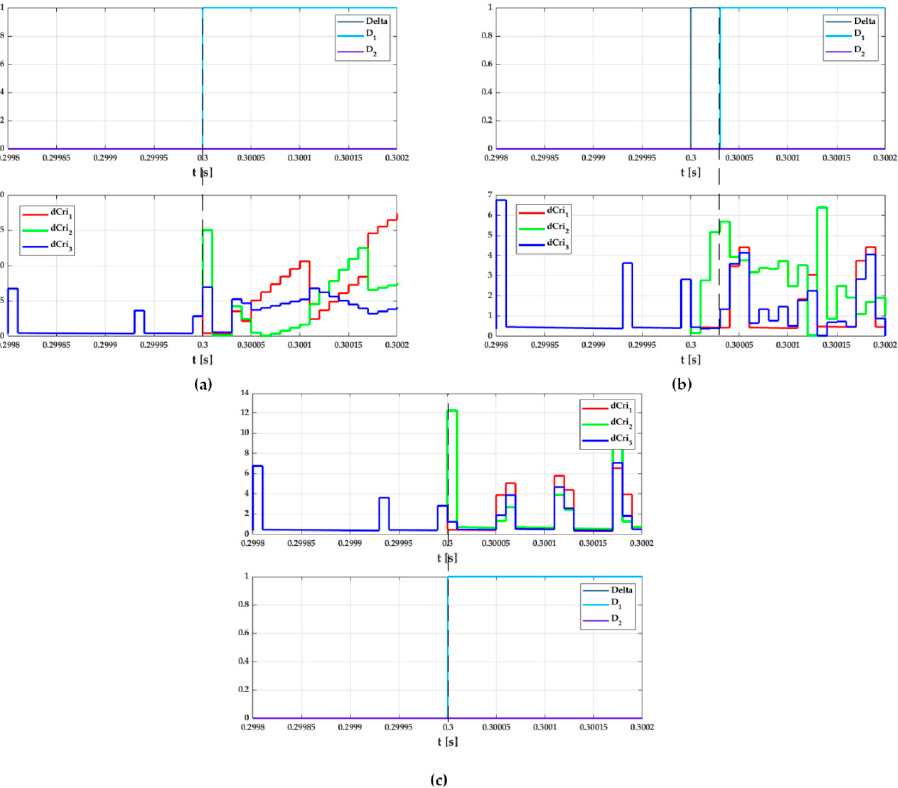
Figure 3. Detector responses and transients of marker errors during lack of signal: ( a ) measurement white Gaussian noise (20 dB); ( b ) variable gain (1.2 i a ) ; ( c ) in phase A in simulation tests.